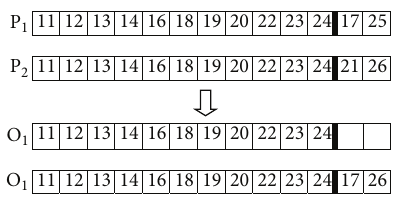
Figure 3: Offspring generated during crossover.